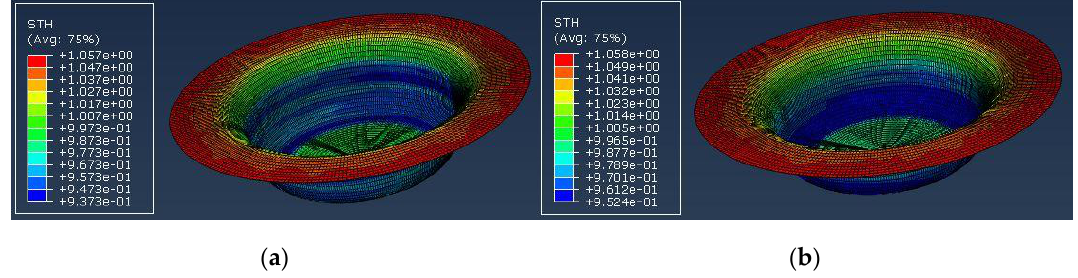
Figure 11. Thickness variation distribution demonstrated by the numerical simulation under different compromise solutions: ( a ) compromise solution 1, ( b ) compromise solution 2.